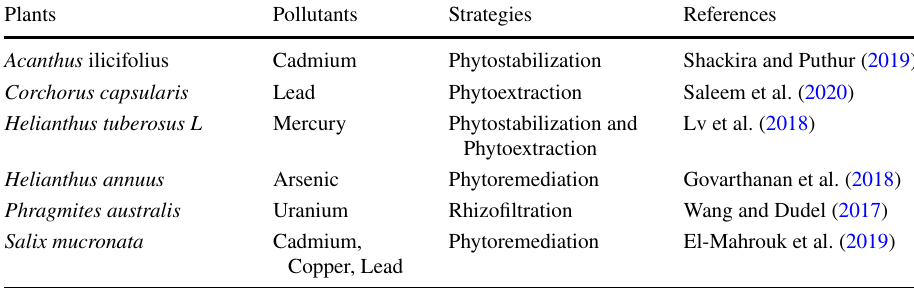
Table 2 Phytoremediation of heavy